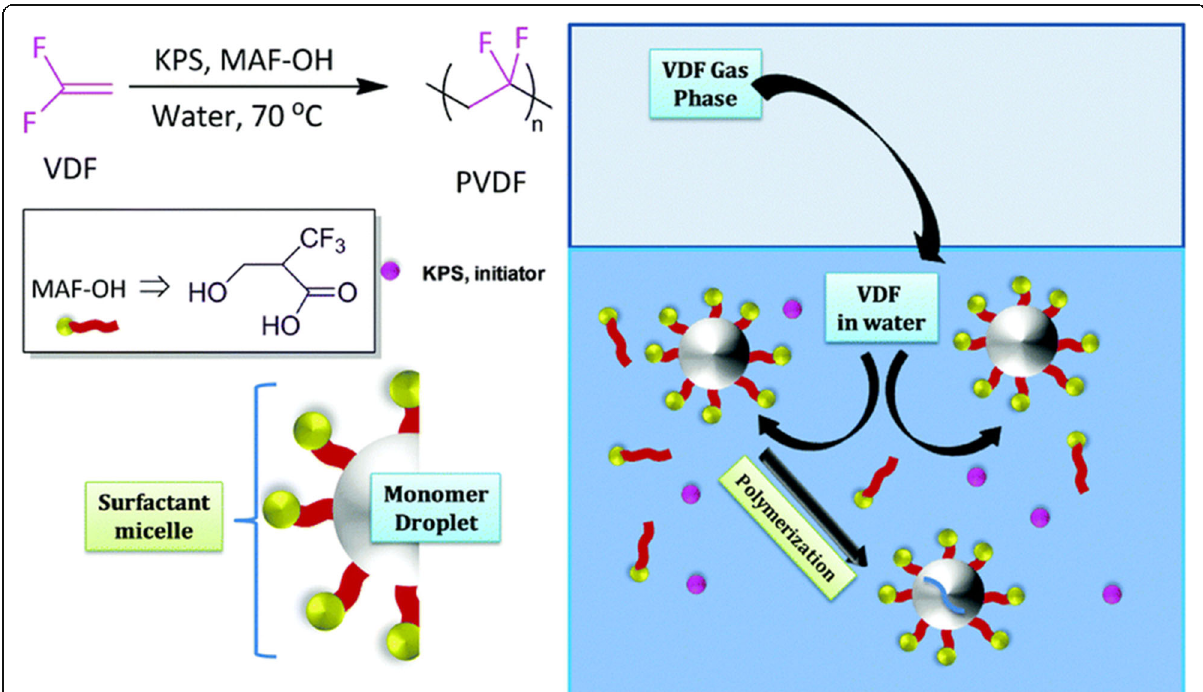
Fig. 5 Emulsion polymerization of VDF [93]. Copyright 2018, Royal Society of Chemistry